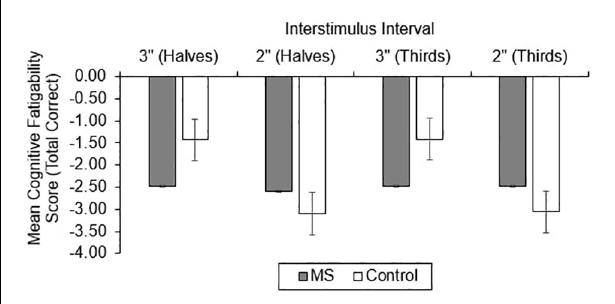
FIGURE 1 | Group difference in total correct performance scores.